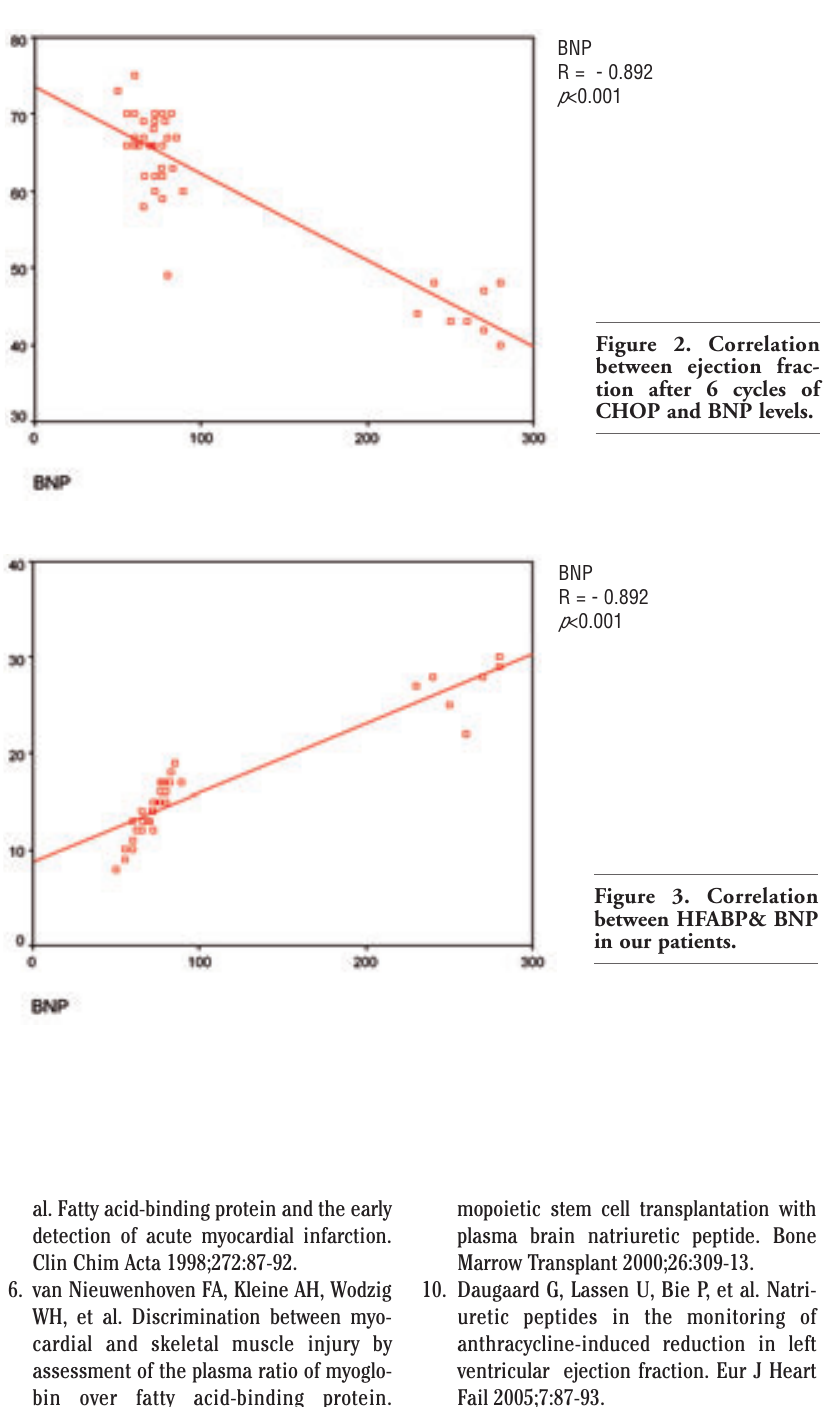
Figure 2. Correlation between ejection frac- tion after 6 cycles of CHOP and BNP